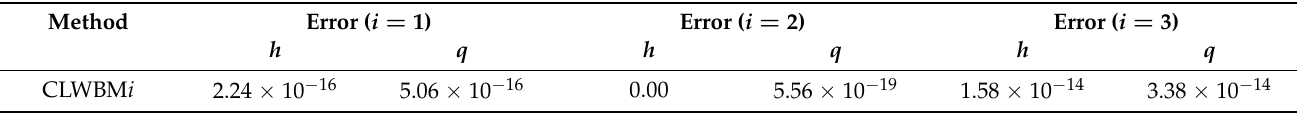
Table 14. Test 4.1. Differences in L 1 -norm with respect to the stationary solution for CLWBM i ( i = 1,2,3) for the 200-cell mesh at time t = 1 s.